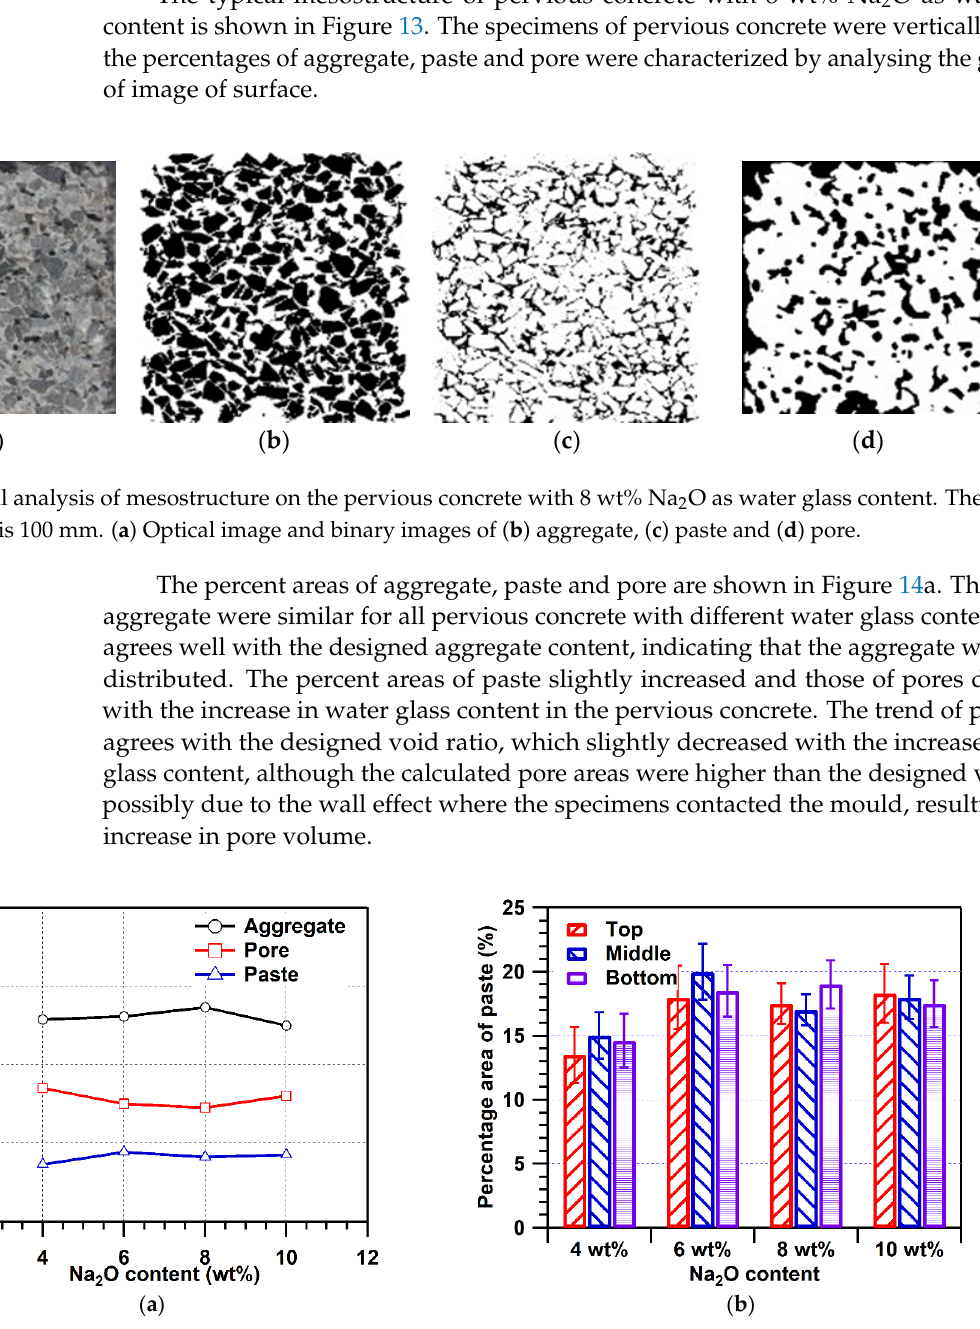
Figure 12. Sedimentation degree (as percent area of paste and aggregate) on the bottom of pervious concrete with different water glass content.